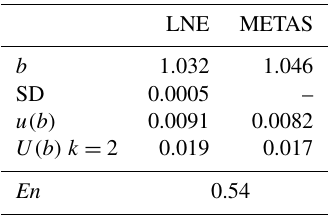
Table 9. The result comparison between LNE and METAS. b is the slope of the calibration functions (no units). SD is the standard deviation of the calibration slopes obtained by LNE between 15– 27 May 2020 (no units). u(b) is the standard uncertainty of the slope determination (no units). U(b) is the expanded uncertainty of the slope determination, and k is its coverage factor (no units). En is the normalized deviation between LNE and METAS slopes (no